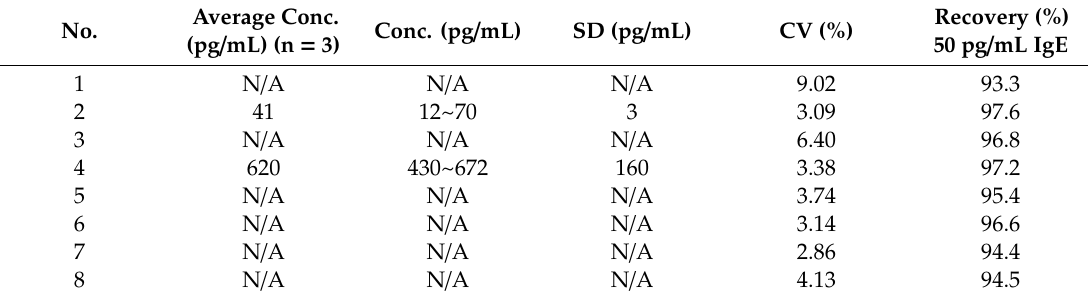
Table 2. IgE from human urine sample analyzed by the developed